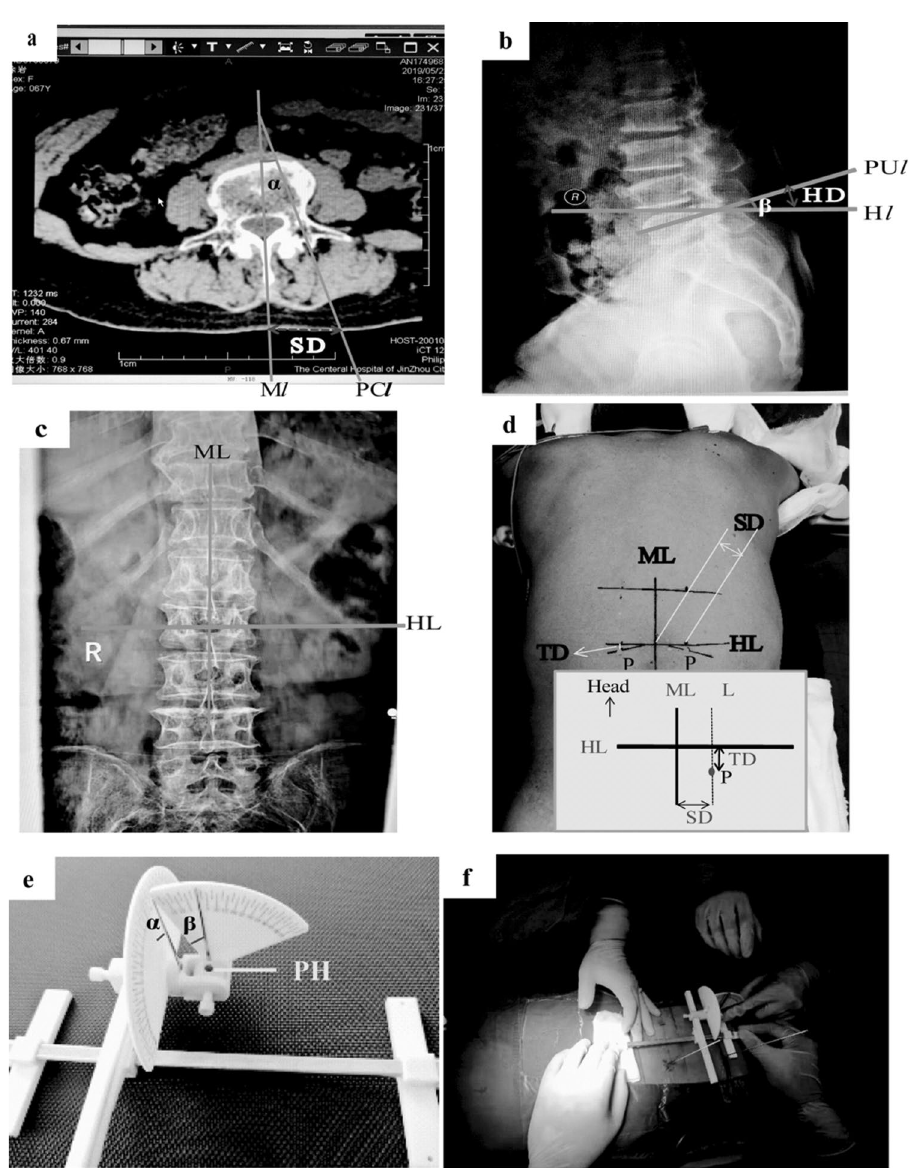
Figure 2. Four lines, two distances, and two angles presented for application of the locator in a surgery. Graph ( a ) show M l and PC l lines, SD, and angle α in a cross-sectional CT image; Graph ( b ) displays PU l and H l lines, H/TD, and angle β in a lateral X-ray image. Graph ( c ) illustrates ML and HL lines on the body surface using an X-ray image. Graph ( d ) shows ML and HL lines, SD and H/TD, and point P on the body surface. Graph ( e ) depicts angles α and β on the two scale dials of the locator. Graph ( f ) shows the practical utilization of the locator. M l and ML, linear median posterior; PC l , pedicle channel line; PU l , needle entry point on pedicle; H l and HL, horizontal lines; SD, side opening distance; H/TD, head or tail tilt distance; angle α, extroversion angle; angle β, head or tail tilt angle; P, percutaneous puncture point; PH, a needle passing through the skin to the target point (pinhole